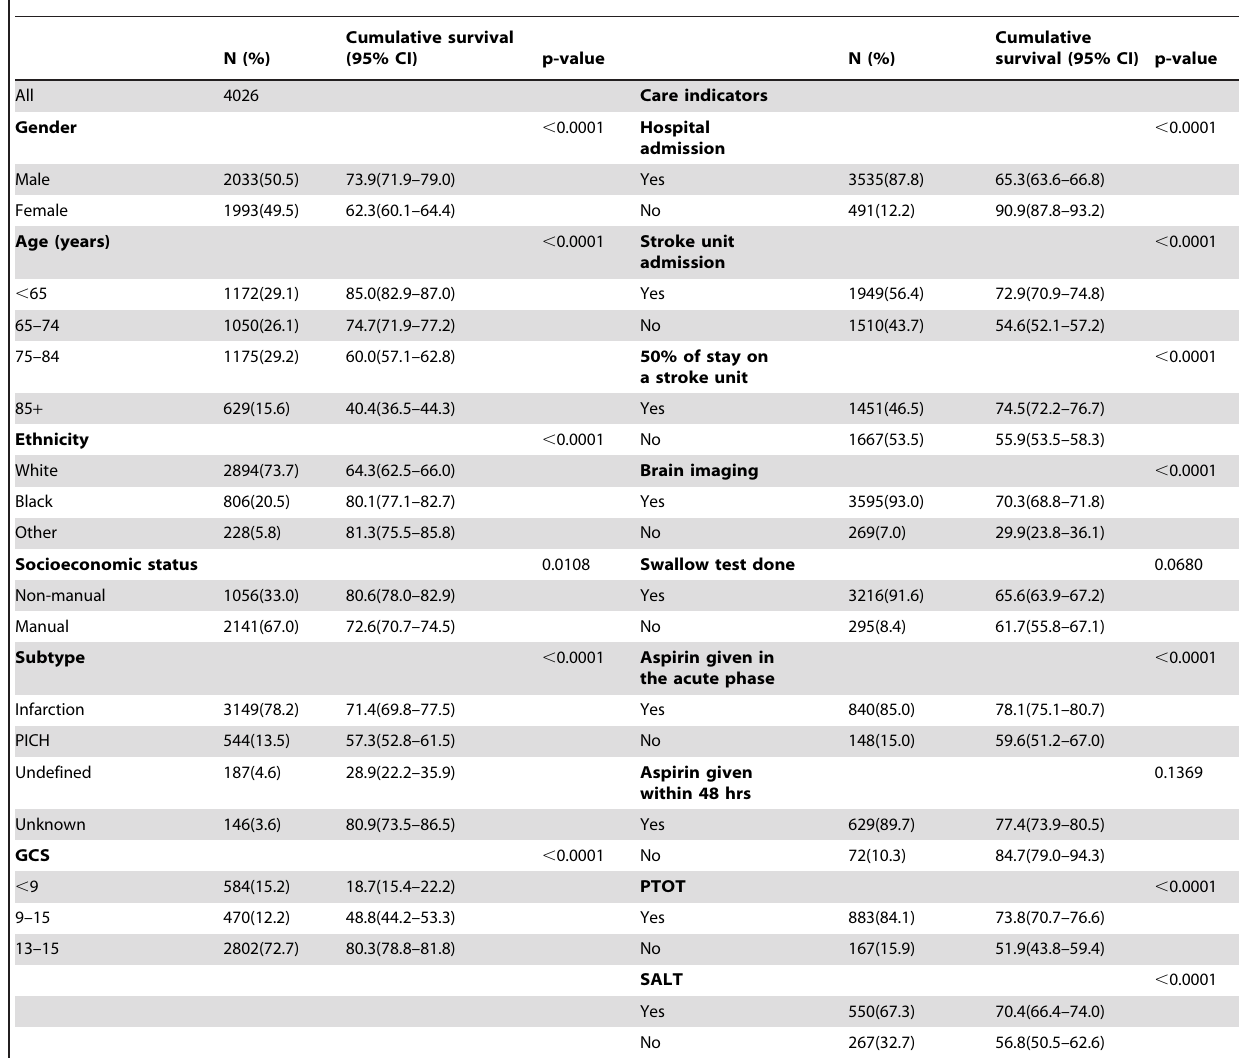
Table 1. General characteristics and cumulative survival at one year post